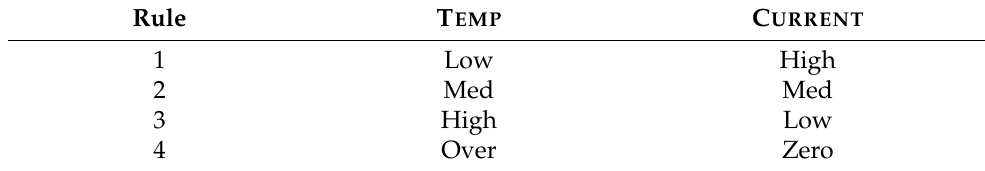
Table 2. The rule base of the FIS consists of the following four IF-THEN rules. Rule T EMP C URRENT 1 Low High 2 Med Med 3 High Low 4 Over